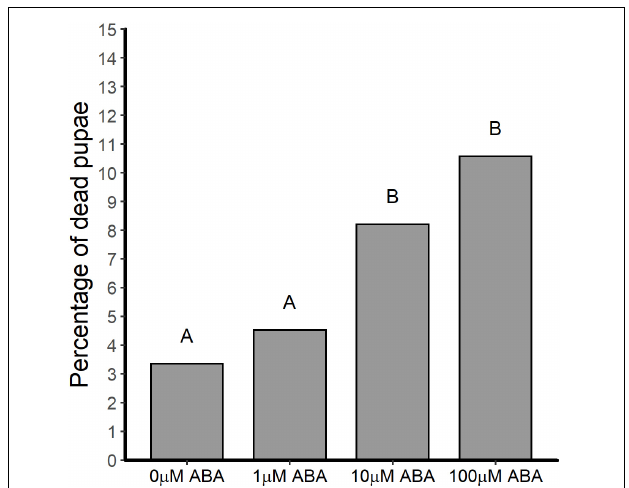
FIGURE 3 | ABA treatment of larval A. stephensi increased the percentage of pupae dying prior to adult eclosion. While treatment of A. stephensi larvae with 1 µ M ABA had no effect on pupae death relative to control (Gtest p = 0.249), larvae that were exposed to 10 and 100 µ M ABA exhibited increased percentages of pupae death compared to control larvae (Gtest p < 0.001 and p < 0.001, respectively). Data are represented as percentages of pupae out